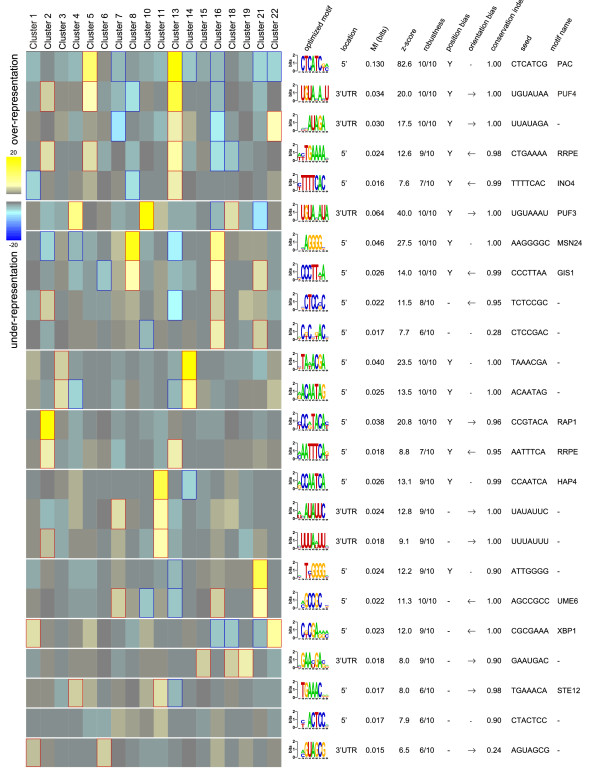
FIRE analysis for transcriptional regulatory motifs occurring in the clusters presented in figure 2. For each cluster, the most significant GO enrichments are shown at the top. Yellow indicates over-representation of a motif in a given cluster and significant (p < 0.05) overrepresentation is highlighted with red frames. Similarly, blue blocks and blue frames indicate significant (p < 0.05) under-representation. For each motif, the location (either 5' upstream or 3' UTR), mutual information (MI) value, Z score associated with the MI value, a robustness score ranging from 1/10 to 10/10, a position bias indicator ("Y" indicates position bias is observed), orientation bias indicator, conservation index, the seed that gave rise to the motif and name of the closest known motif are presented. For more details, see Elemento and co-workers 2007 [35].